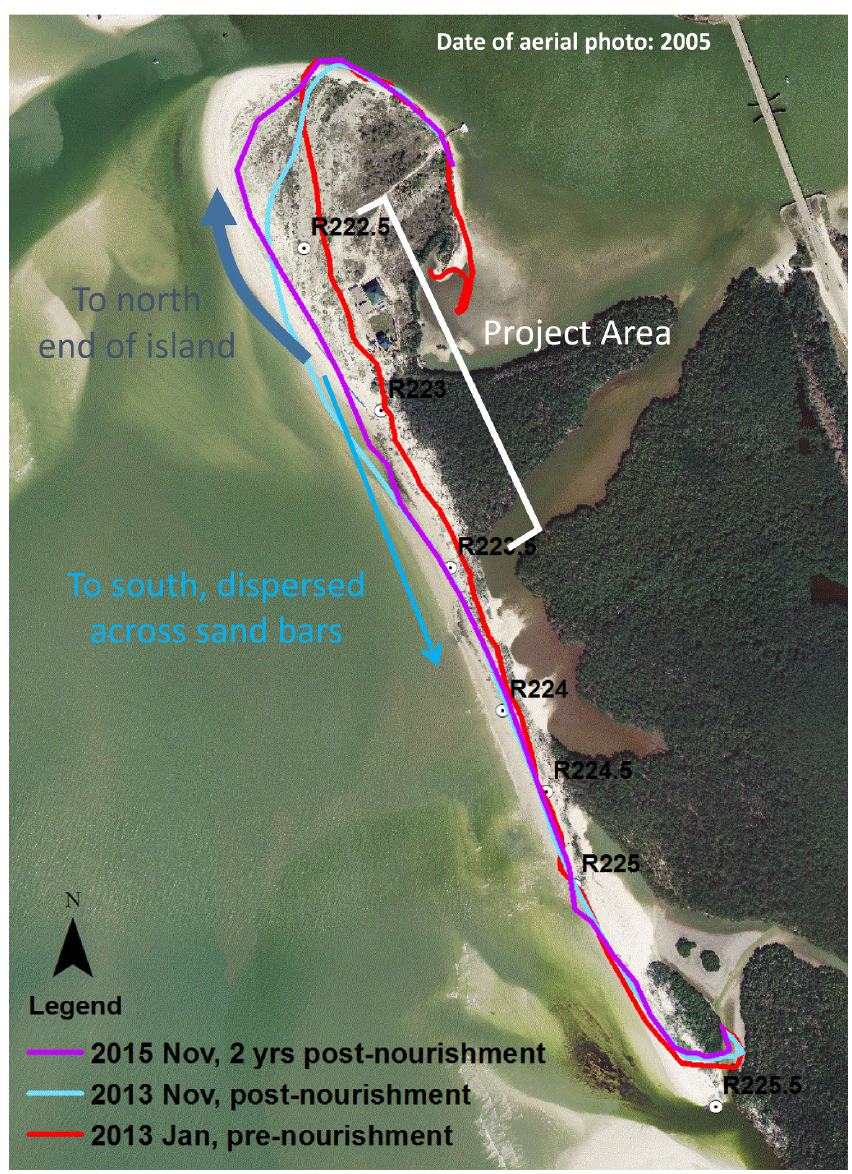
Figure 9. Conceptual model of the post-project generalized directions of sediment movement along Big Hickory Island, suggested from observations in this study.